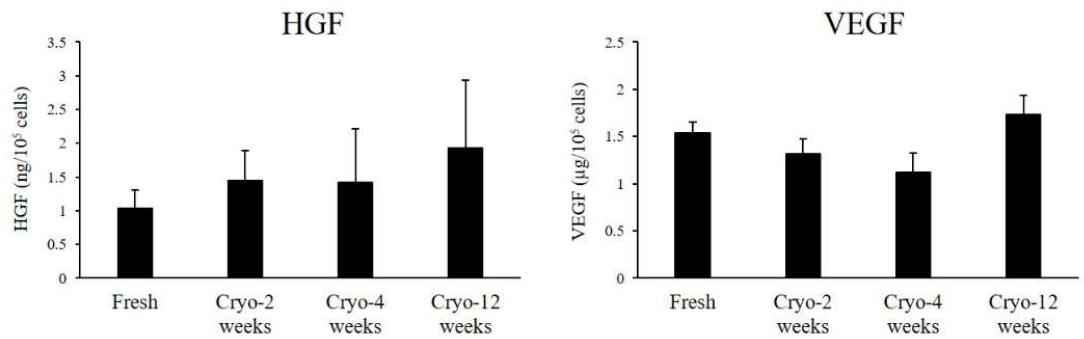
Figure 4. Cytokine secretion from ASCs. P2-ASCs were cultured for four days. Supernatants were harvested for cytokine assay. Hepatocyte growth factor (HGF) and vascular endothelial growth factor (VEGF) in the culture medium were measured by enzyme-linked immunosorbent assay. Data are expressed as the mean ± SE ( n = 4).